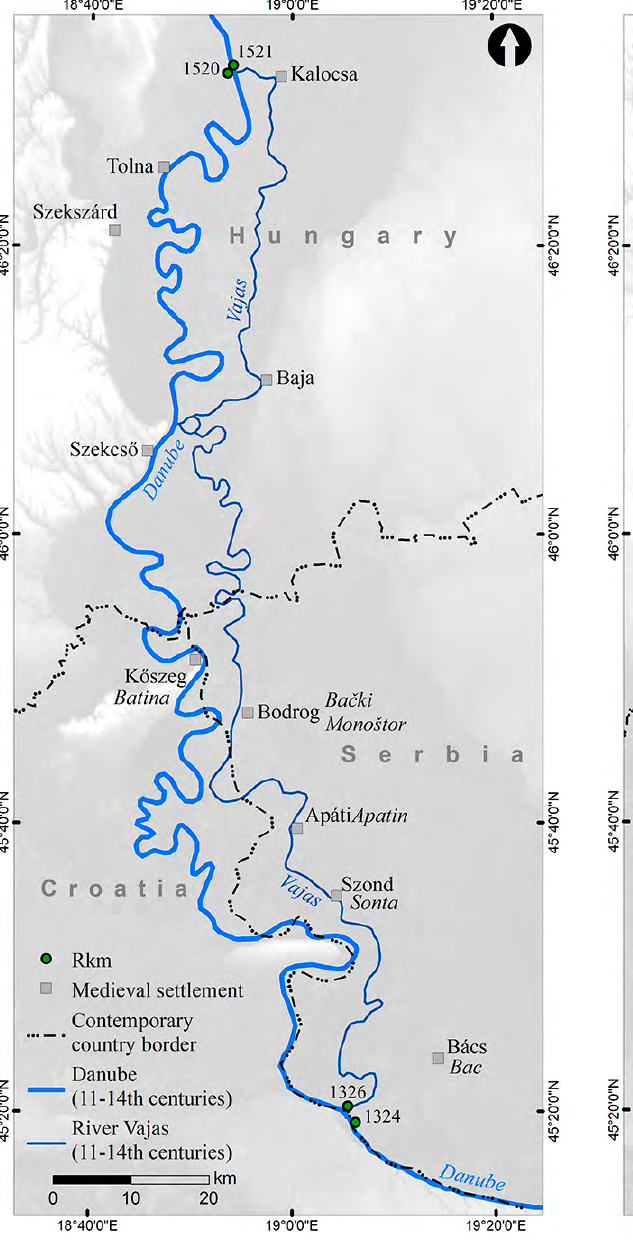
Figure 2. The identified sections of the River